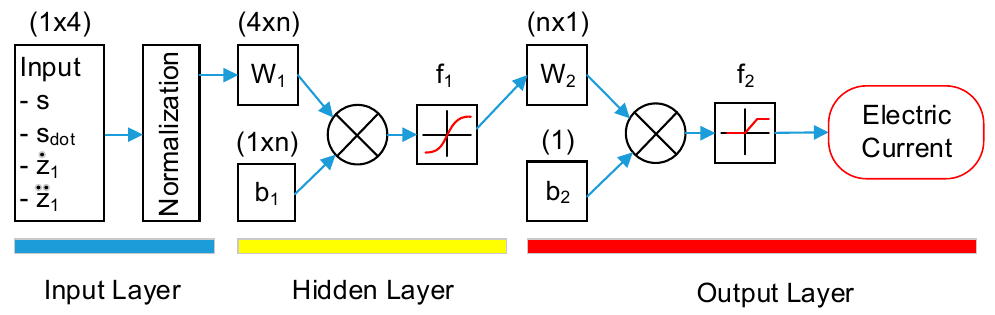
Figure 3. Neural network structure.